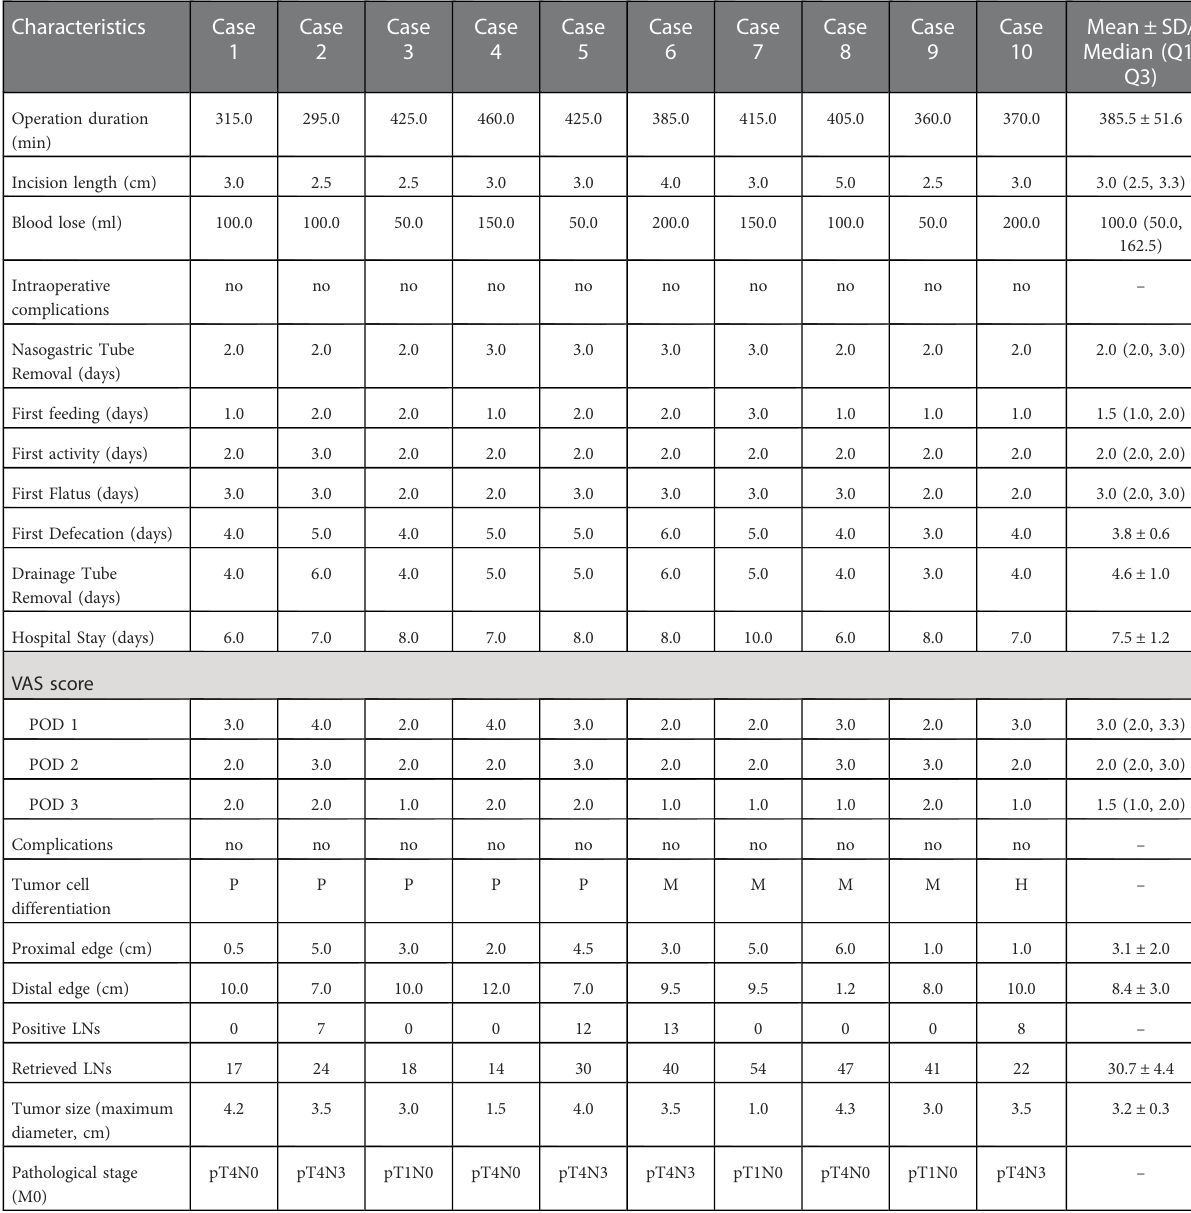
TABLE 2 Perioperative situations and postoperative pathological examination.